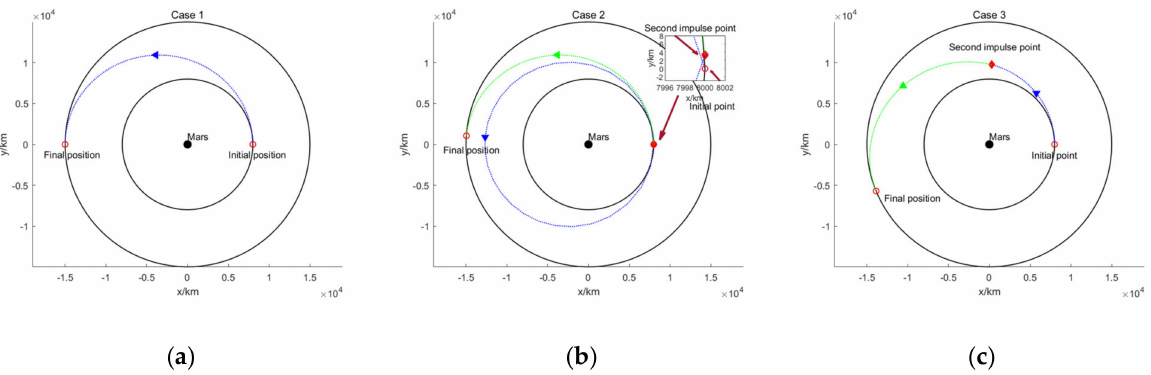
Figure 14. The orbit transfer of ( a ) Case 1; ( b ) Case 2; ( c ) Case